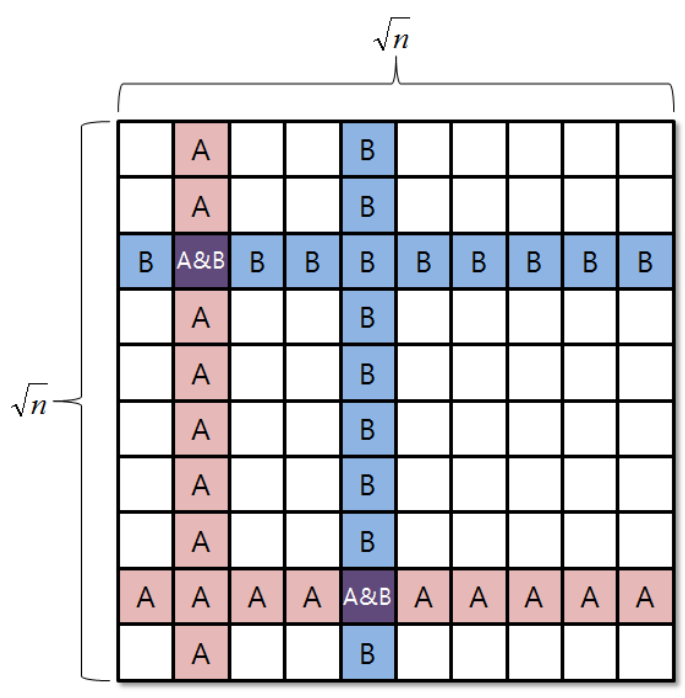
Figure 2. Grid Quorum